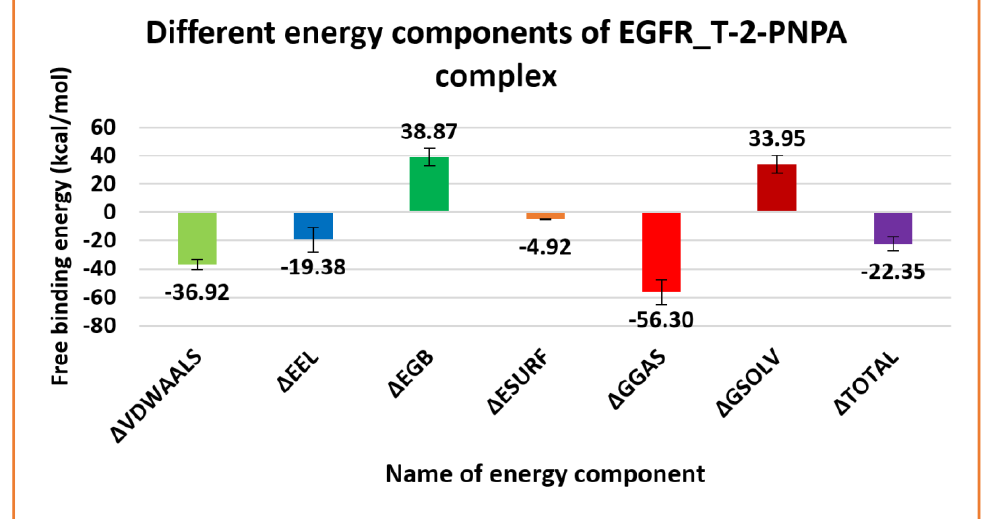
Figure 8. MM-GBSA of EGFR – T-2-PNPA complex showing energetic components and their average energy values. Bars denote the standard deviation.